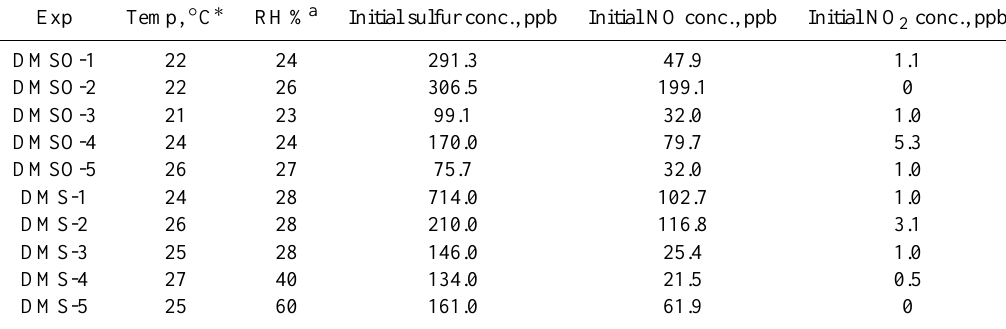
Table 2. Chamber experimental conditions for isoprene photooxidation with and without DMS. Exp Temp, ◦ C a RH% a Initial DMS conc., ppb Initial isoprene conc., ppb Initial NO conc., ppb Initial NO 2 conc., ppb iso-1 24.5 30 0 644 66.7 10.2 iso-2 25.0 32 0 600 20.0 6.7 iso-DMS-1 23.5 28 243 560 77.3 7.5 iso-DMS-2 23.2 30 265 1360 79.9 4.6 iso-DMS-3 23.0 30 276 2248 62.0 3.9 iso-DMS-4 22.0 10 31 210 39.0 1.3 iso-DMS-5 23.1 30 20 b 40 b 15.6